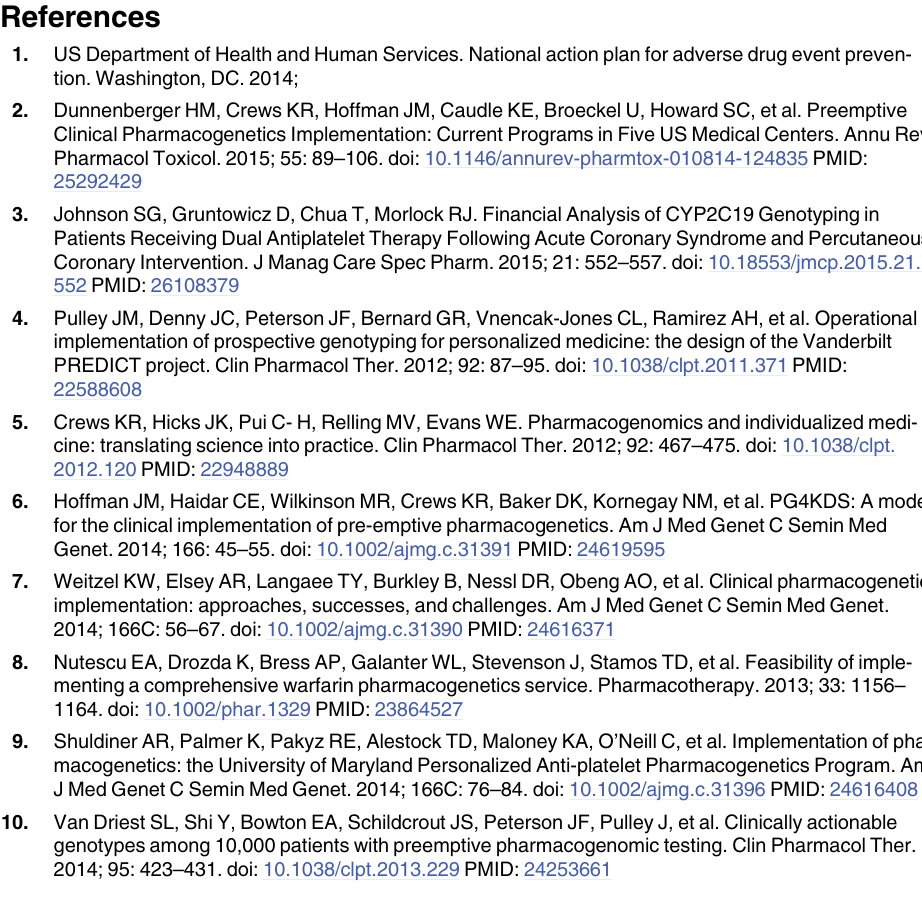
S7 Table. Drug-phenotypeco-occurrenceoverall